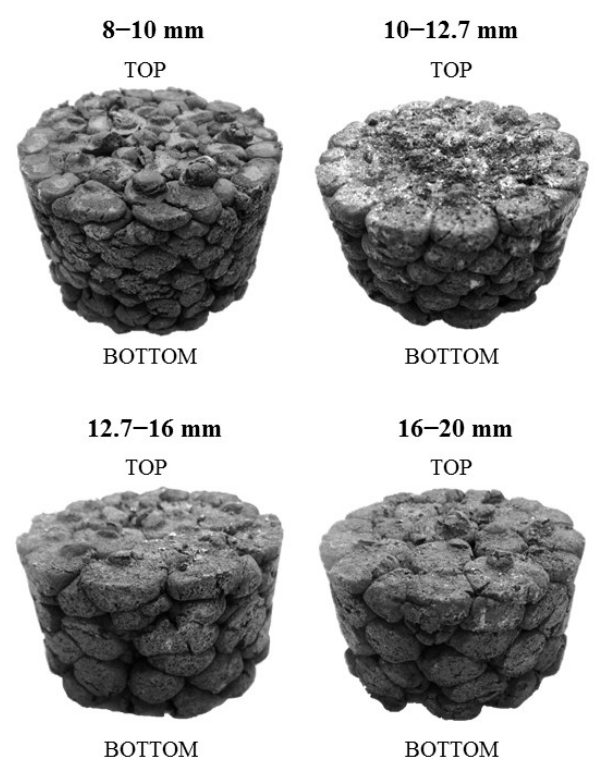
Figure 9. Digital images of the samples after the reduction-softening tests.